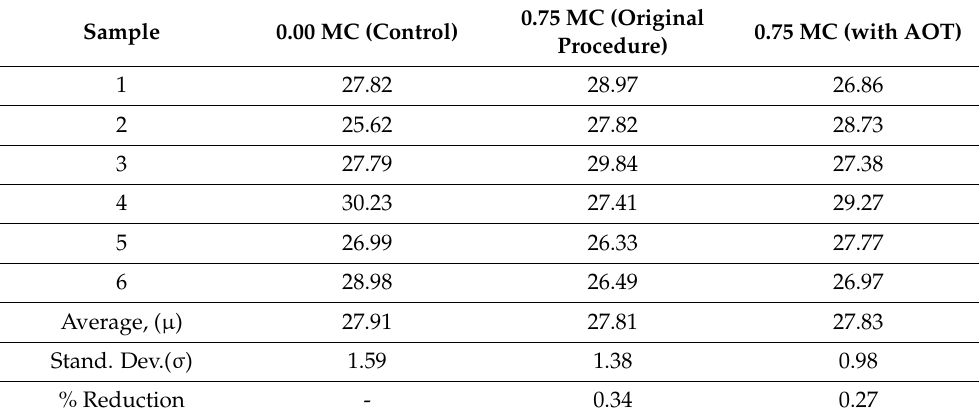
Table 4. Seven-day mortar compressive strength test results,